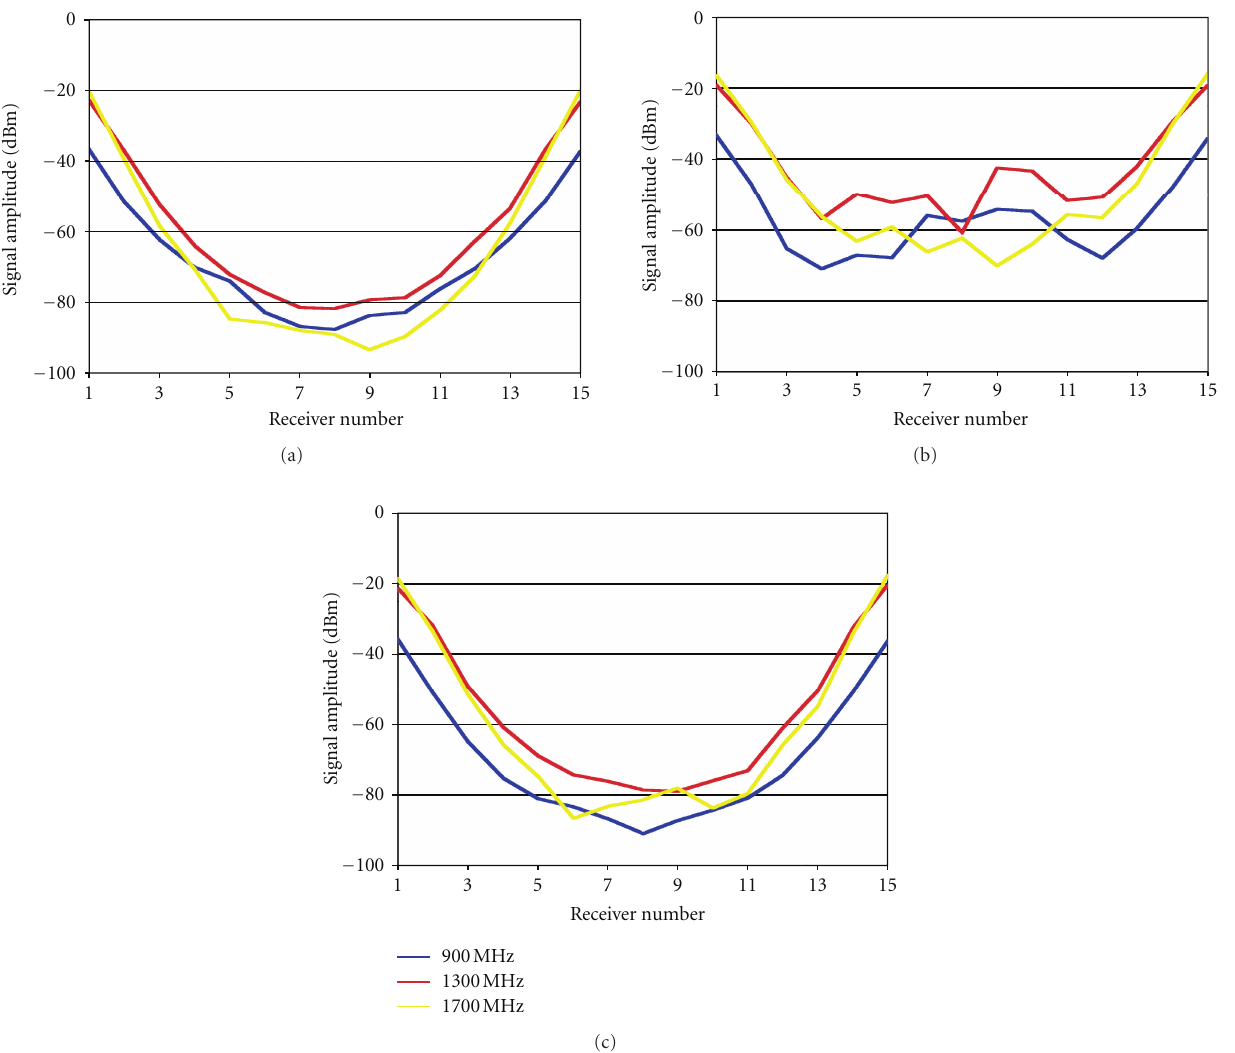
Figure 8: Signal amplitudes measured at the receivers for a single transmitter in the experimental imaging tanks in Figure 5 at 900, 1300, and 1700 MHz with the (a) 10 cm straight, (b) 5 cm straight, and (c) 10 cm curved coaxial feedlines,